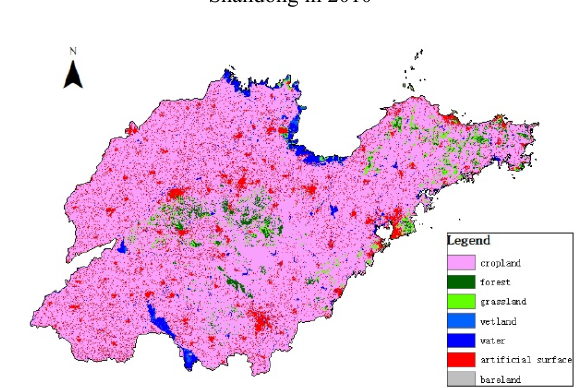
Figure 3. The GlobeLand30-2010 product in Shandong